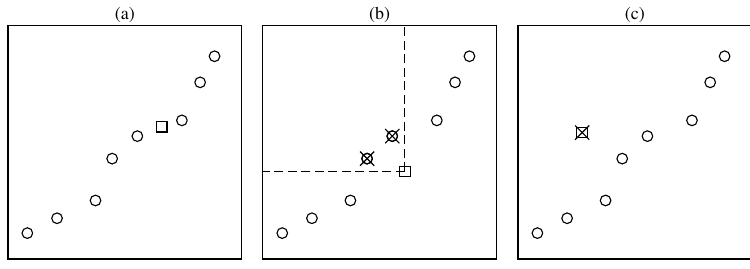
Figure 1. Illustration of three cases of the newly generated decision